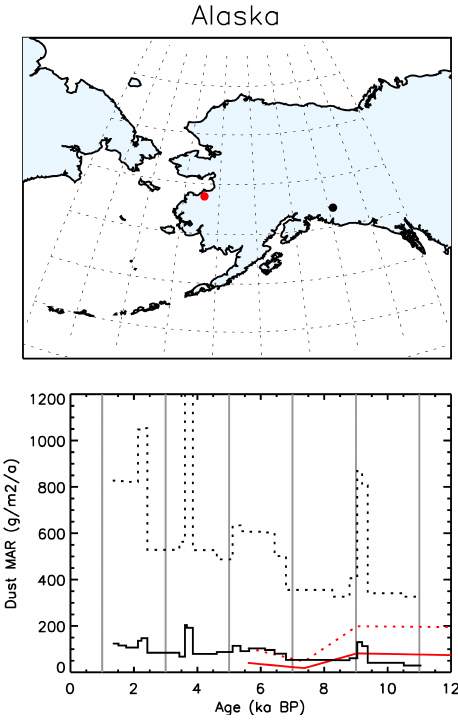
Figure 9. Same as Fig. 6 but for Alaska. Figure 10. Same as Fig. 6 but for eastern Asia and the North Pacific